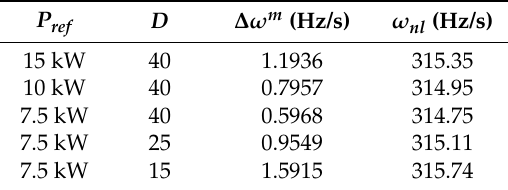
Table 1. No-Load Frequency of Different VSGs.